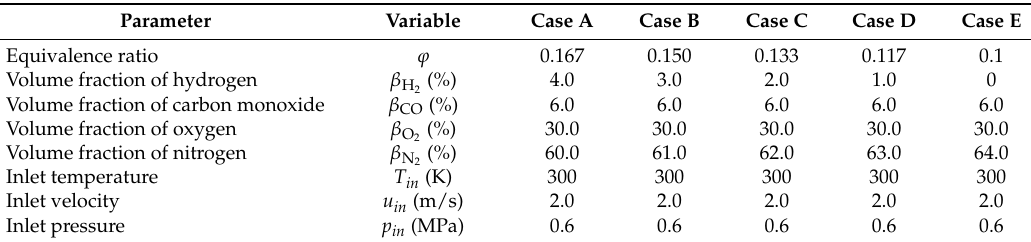
Table 2. Inlet conditions that are used for